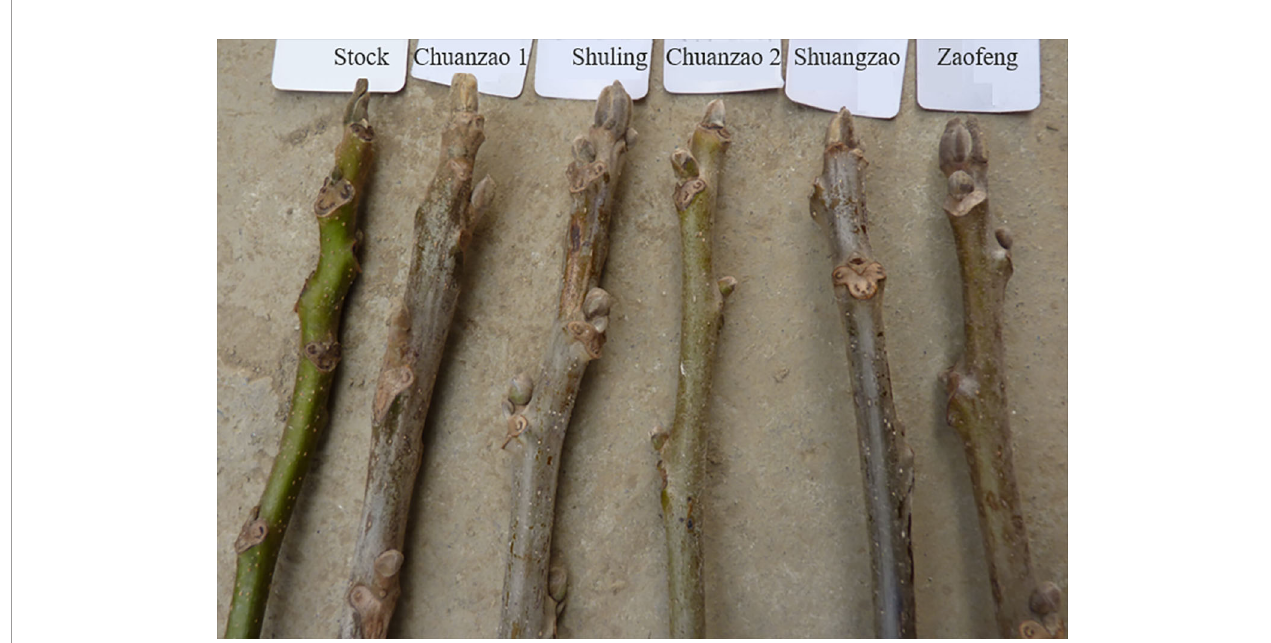
FIGURE 2 | Morphological comparison of engraftment scions of Chuanzao 1, Shuling, Chuanzao 2, Shuangzao, and Zaofeng and their stocks. No distinct characters were observed for any of the engraftment